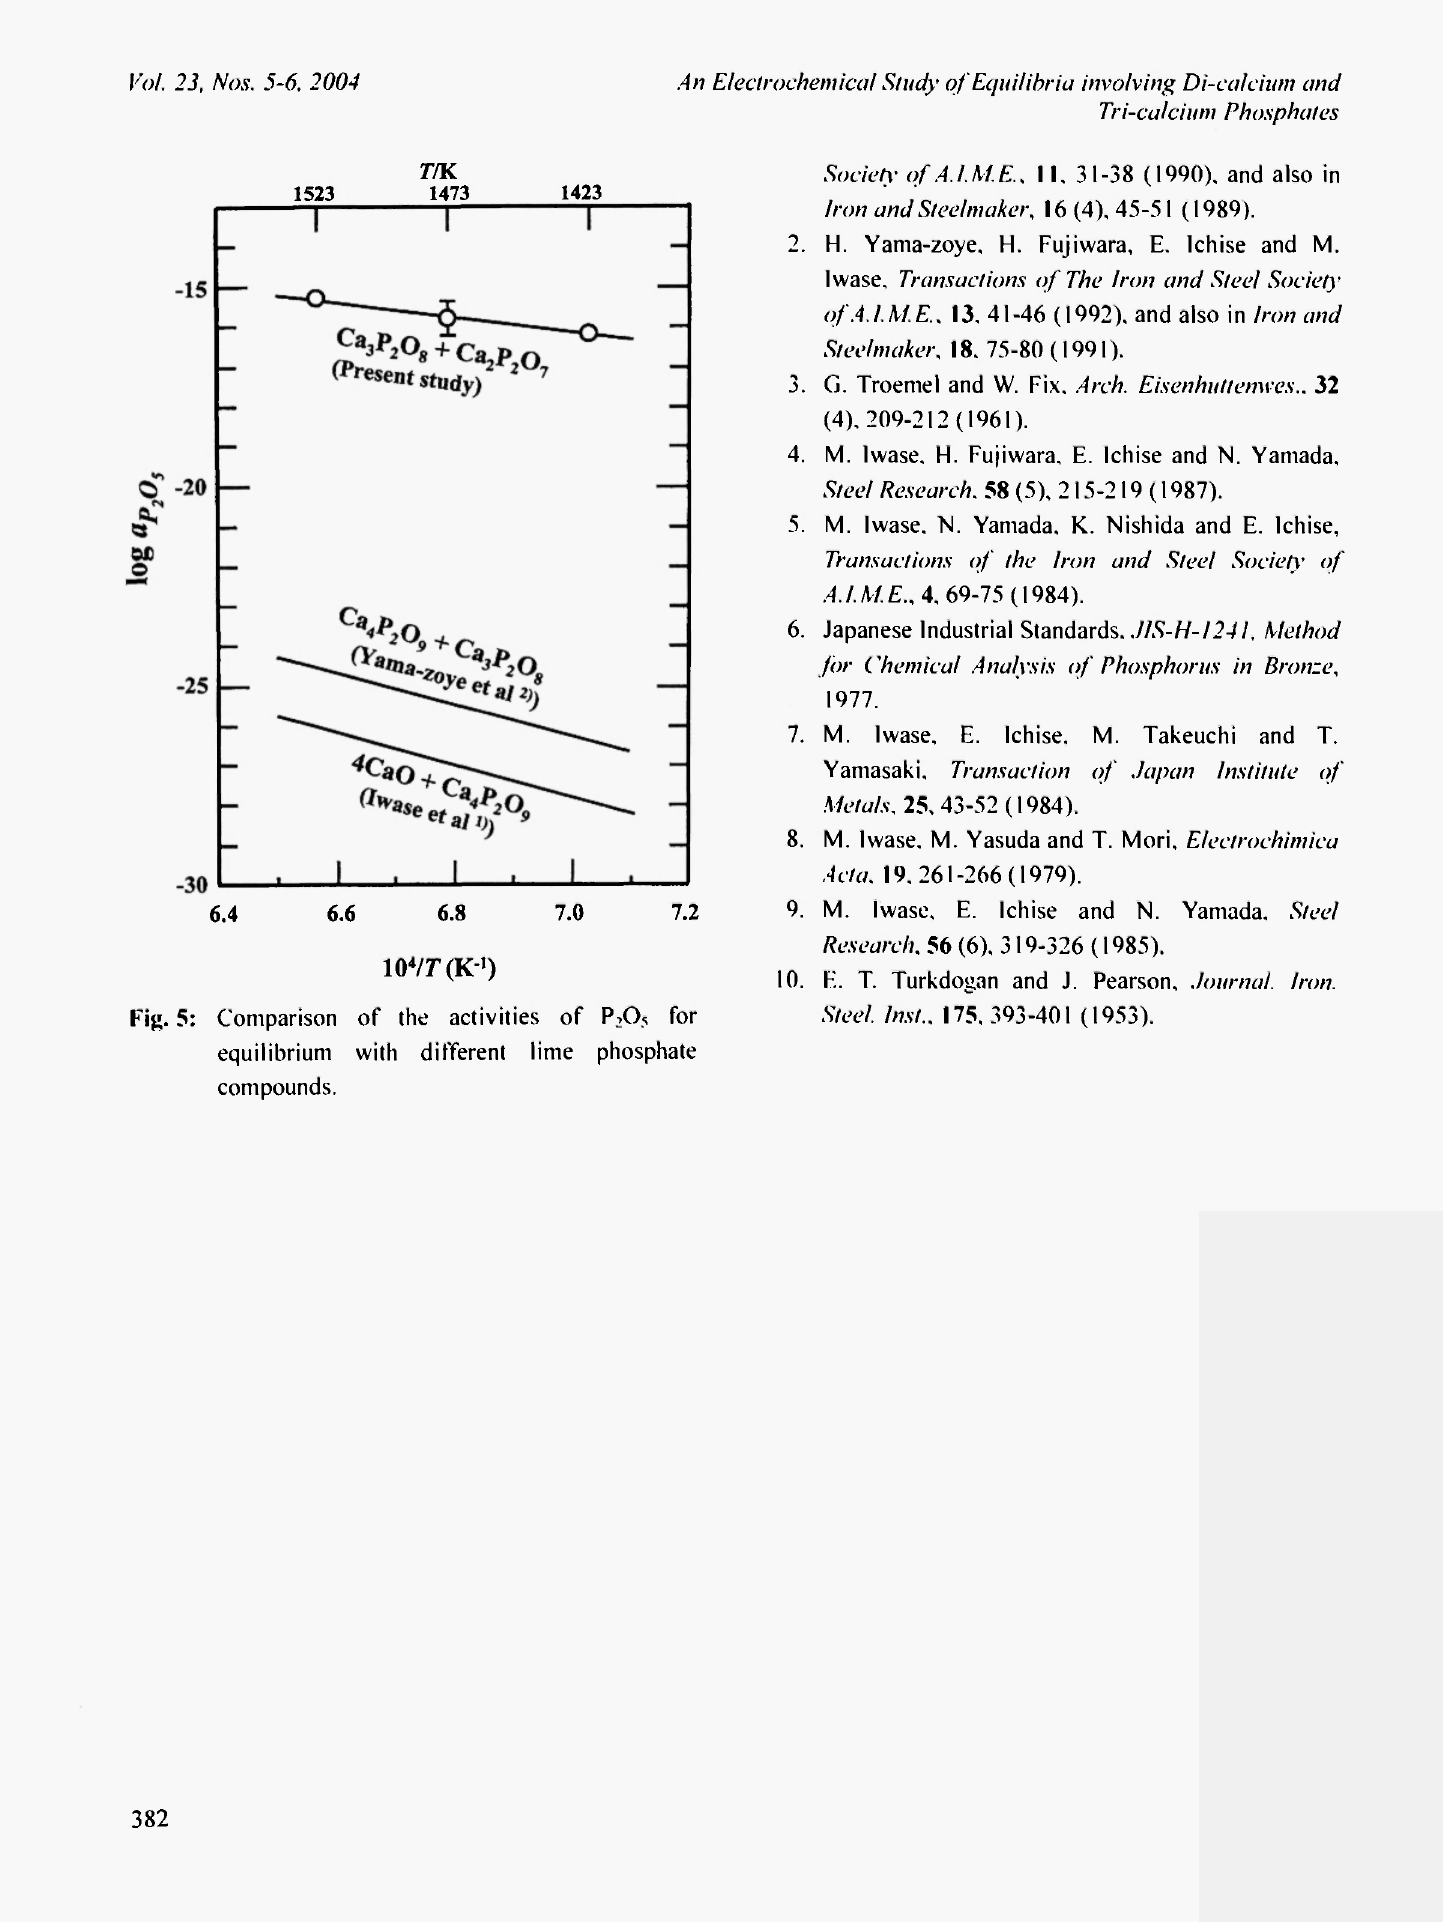
Kig. 5: Comparison of the activities of P 2 0 5 for equilibrium with different lime phosphate